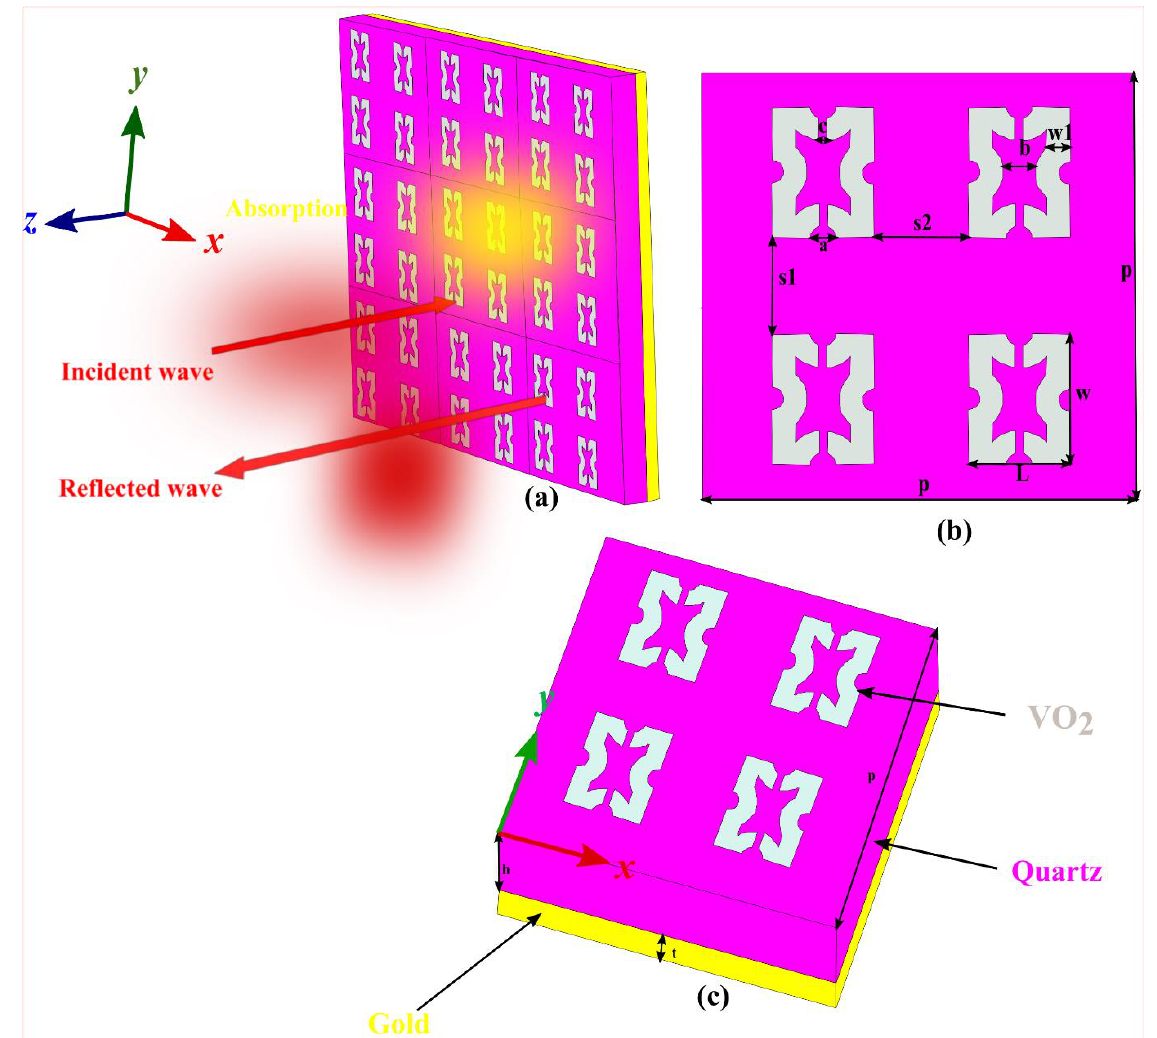
Figure 1. ( a ) 3 × 3 array of the design metasurface; ( b ) the top view of the schematic unit cell; ( c ) three-dimensional view of the proposed planar ultra-wideband unit cell absorber.